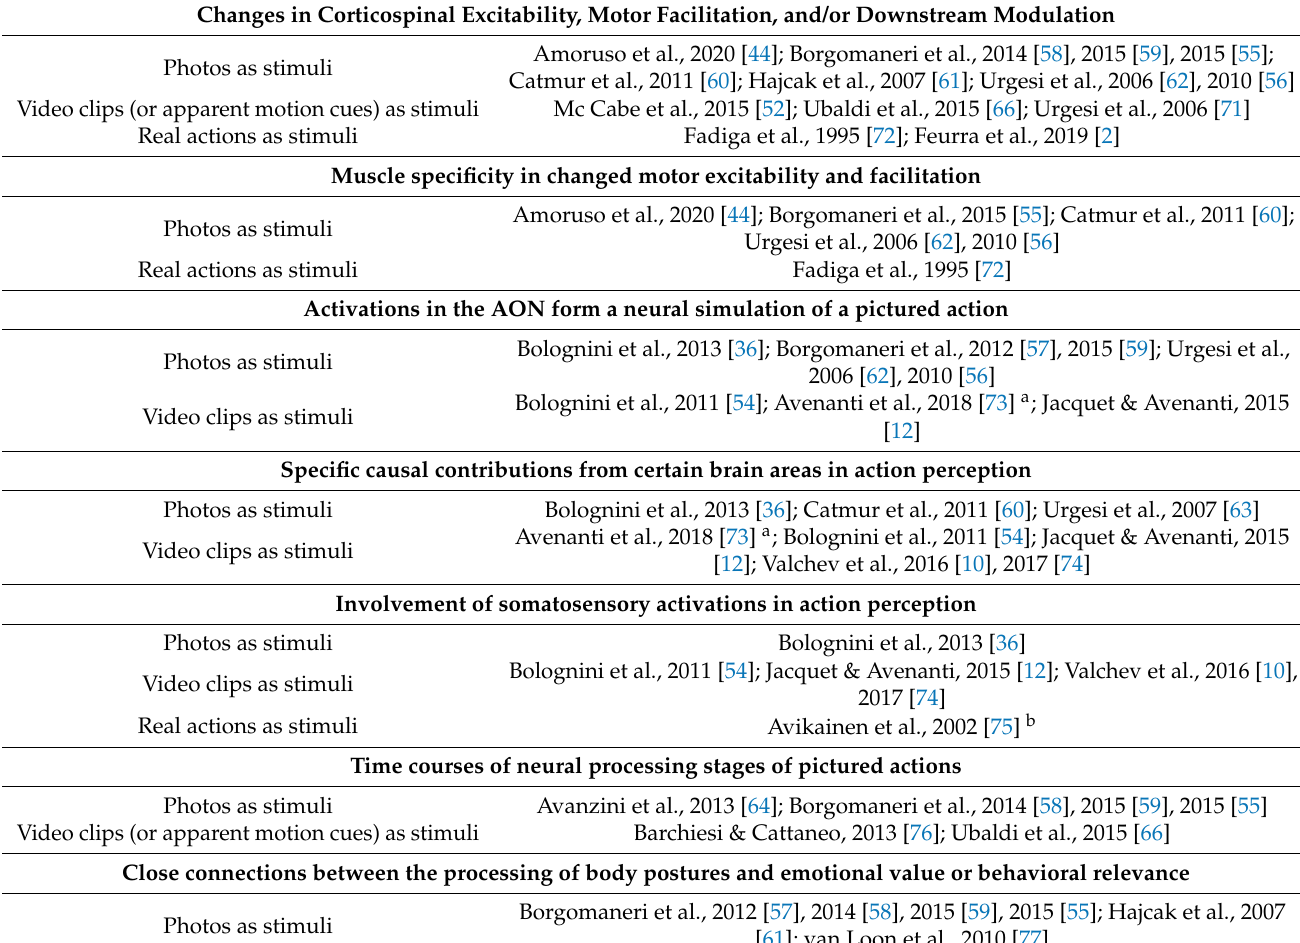
Table 2. Findings on the processing of observed or pictured actions from studies which used transcranial magnetic stimulation (TMS) or methods of non-invasive electrical stimulation. Changes in Corticospinal Excitability, Motor Facilitation, and/or Downstream Modulation Photos as stimuli Video clips (or apparent motion cues) as